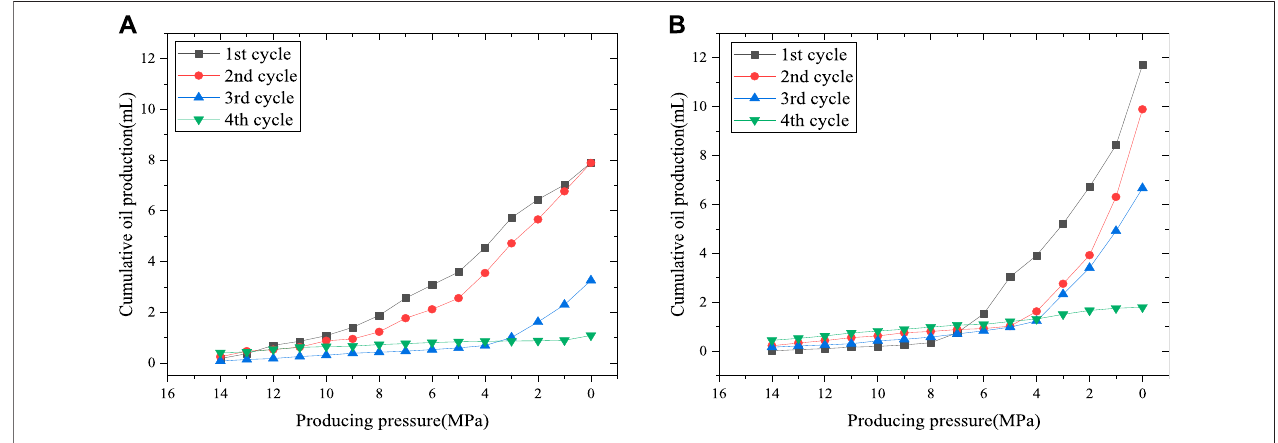
Frontiers in Energy Research |